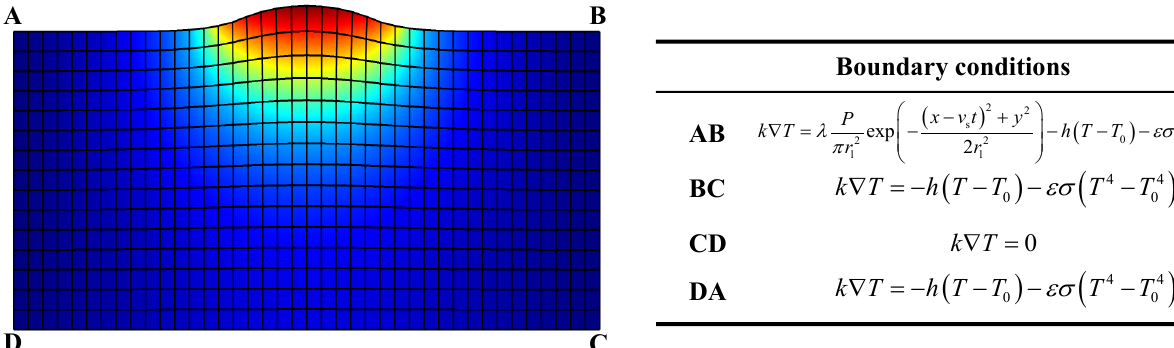
Figure 2. Boundary conditions in the numerical model.